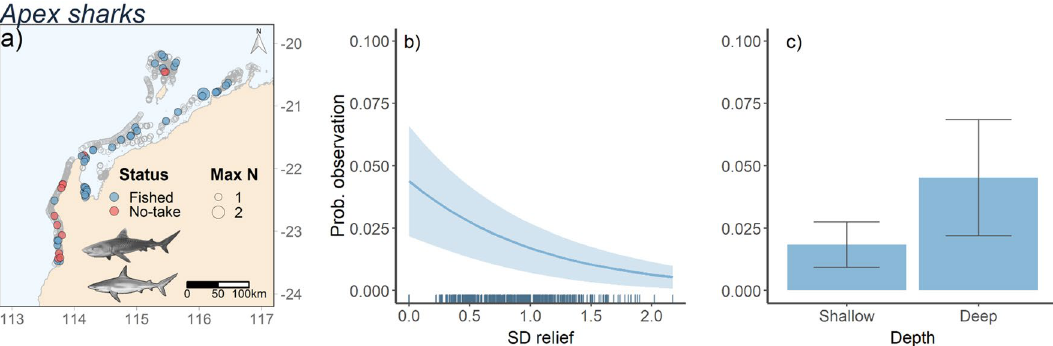
Figure 3. Map of stereo-BRUVS deployments in north-west Australia (indicated by grey open circles. Colour of circles indicates whether the stereo-BRUVS was deployed inside a No-Take Area (red) or in an area where fishing is permitted (Blue). Size of the circle shows the MaxN of apex sharks ( Galeocerdo cuvier, Carcharhinus plumbeus ) in each deployment ( a ). Predicted apex shark probability of occurrence ( a , b ) as functions of variables present in the most parsimonious models (Table 2) from full-subsets GAMM analysis. Ribbons and error bars represent 95% confidence intervals. Figure was generated using R 14 using ggplot2 15 and ggmap 16 .